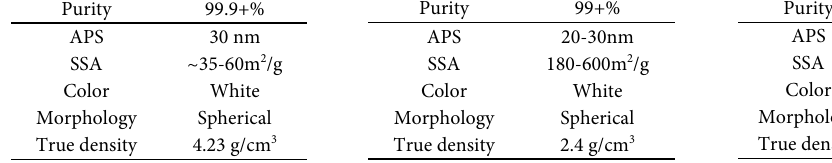
Fig. 3: SEM analysis of Silica Nanoparticles Fig. 4: SEM analysis of the iron oxide Table 3. properties of titania nanoparticle Table 4. properties of Silica nanoparticle Table 5. properties of iron oxide nanoparticle Fig. 4. SEM analysis of the iron oxide nanoparticles Table 4: properties of titania nanoparticle Table 5: properties of Silica nanoparticle Table 6: properties of iron oxide nanoparticle Fig. 3 . SEM analysis of Silica Nanoparticles